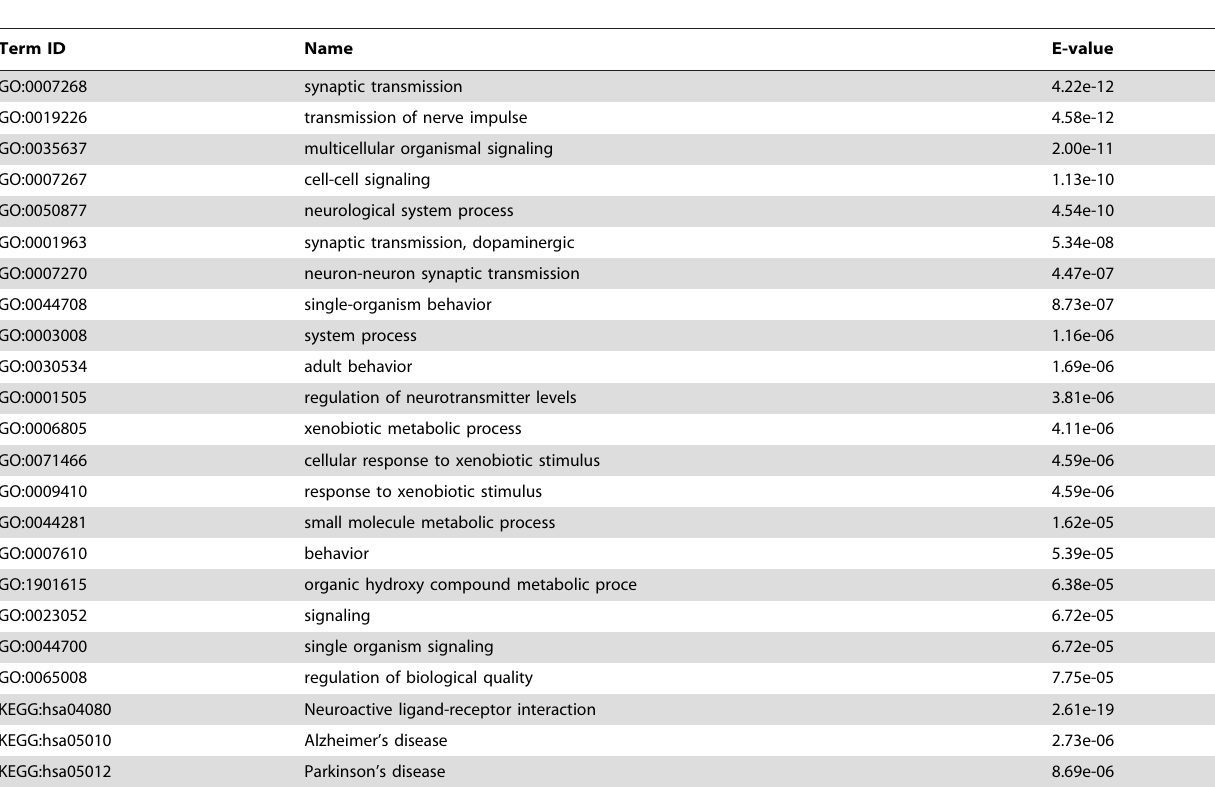
Table 2. Terms associated with the cluster with the highest probability to include the Parkinson’s disease.